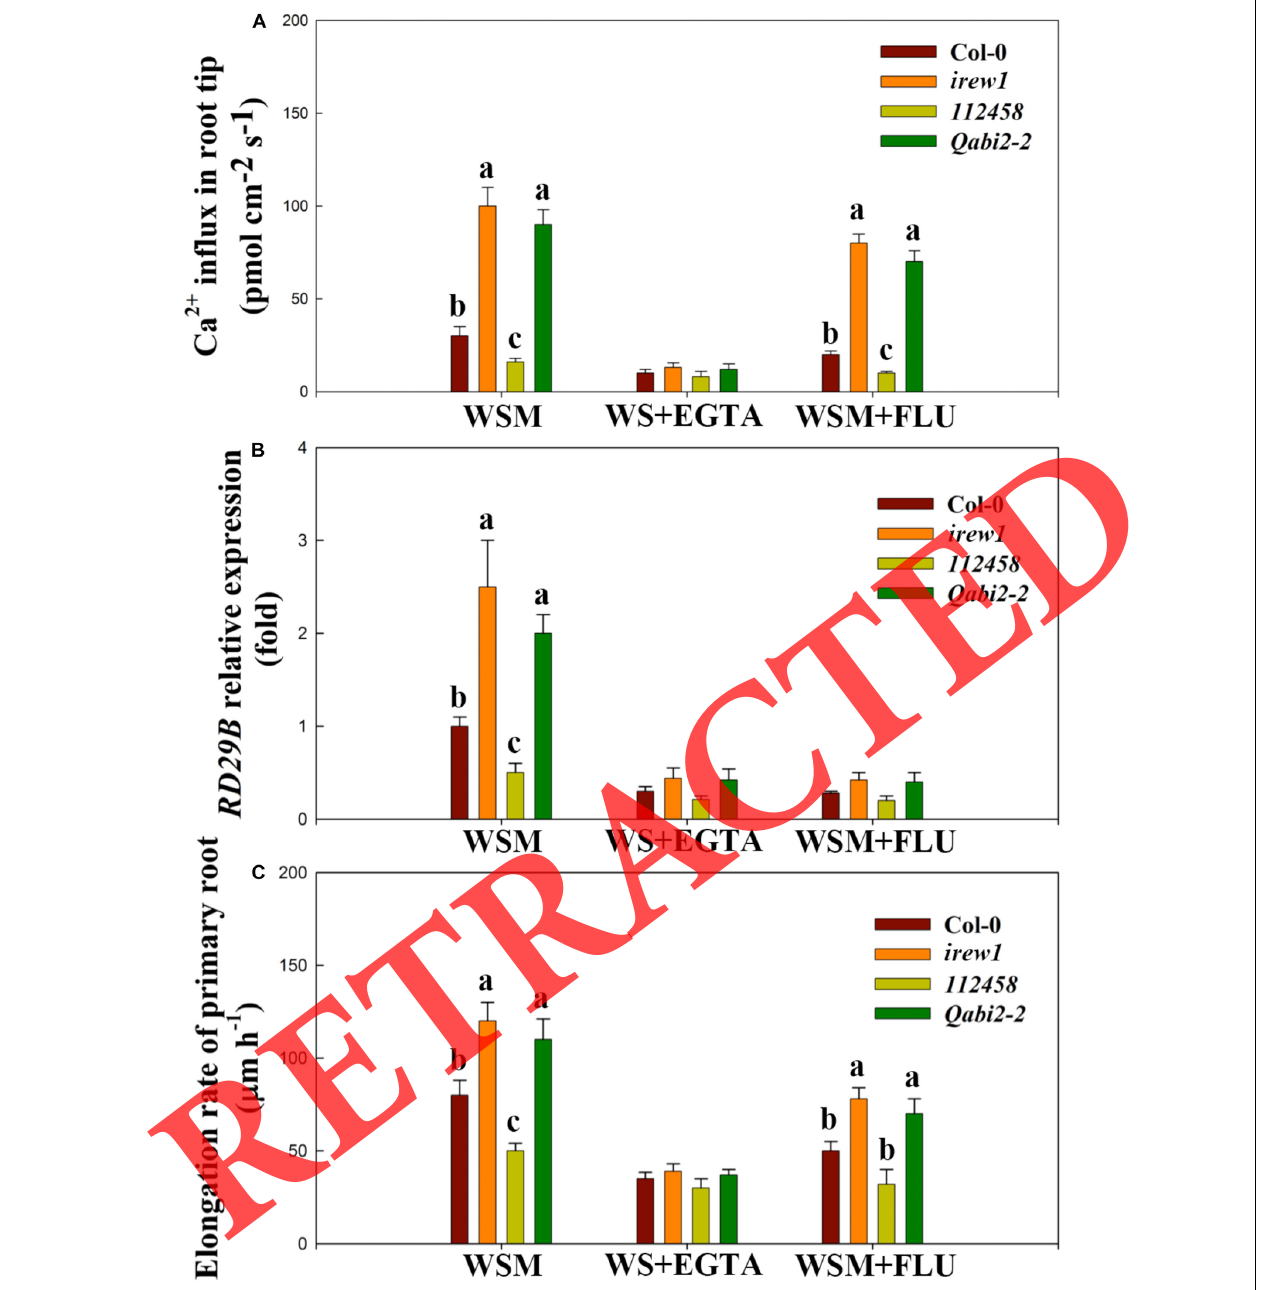
FIGURE 8 | ABA and Ca 2 + are important for Arabidopsis plants under WSM. (A) Ca 2 + influx in the root tips (600–800 mm from the root cap junction) of Col-0, irew1 , 112458 and Qabi2-2 on WSM, WSM with 10 mM EGTA, and WSM with 10 µ M FLU. The values are means, and error bars show ± SD of six biological replicates from three independent experiments ( n = 18). (B) Relative expression levels of RD29B in Col-0, irew1 , 112458 and Qabi2-2 on WSM, WSM with 10 mM EGTA and WSM with 10 µ M FLU. The values are means, and error bars show ± SD of four technical replicates from three independent experiments ( n = 12). (C) Primary root elongation rates of Col-0, irew1 , 112458 and Qabi2-2 on WSM, WSM with 10 mM EGTA and WSM with 10 µ M FLU. The values are means, and error bars show ± SD of four biological replicates from three independent experiments ( n = 12). Bars with different lowercase letters represent significant difference at P < 0.05, as determined by a Tukey’s post hoc